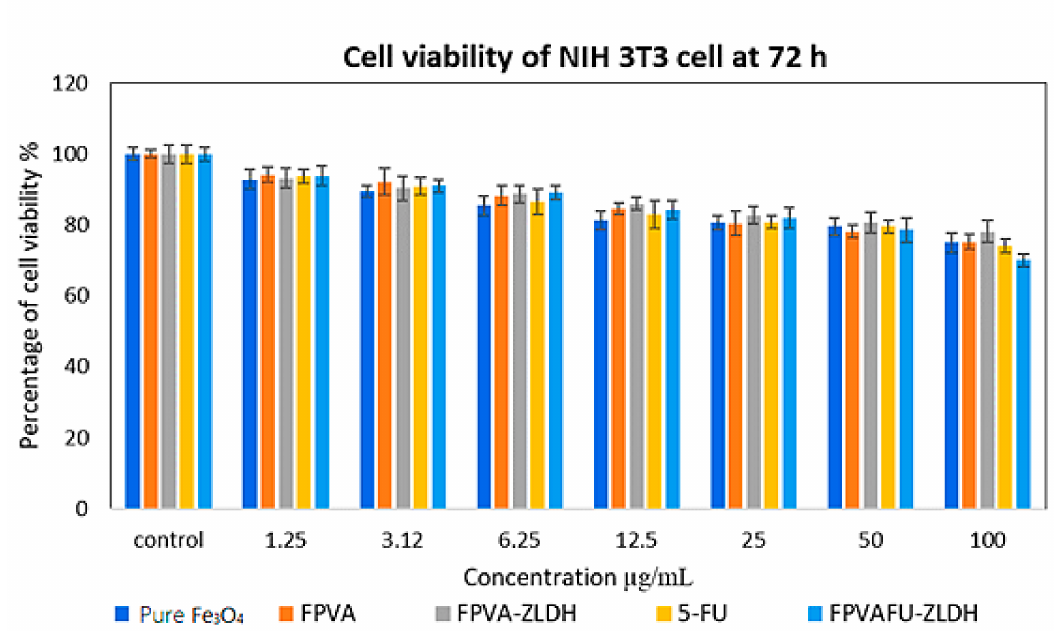
Figure 11. Cytotoxicity assay of pure Fe 3 O 4 nanoparticles, FPVA, FPVA-ZLDH (nanocarriers), pristine 5-FU, and FPVAFU- ZLDH (nanoparticles) against normal human fibroblast (3T3) cells at 72